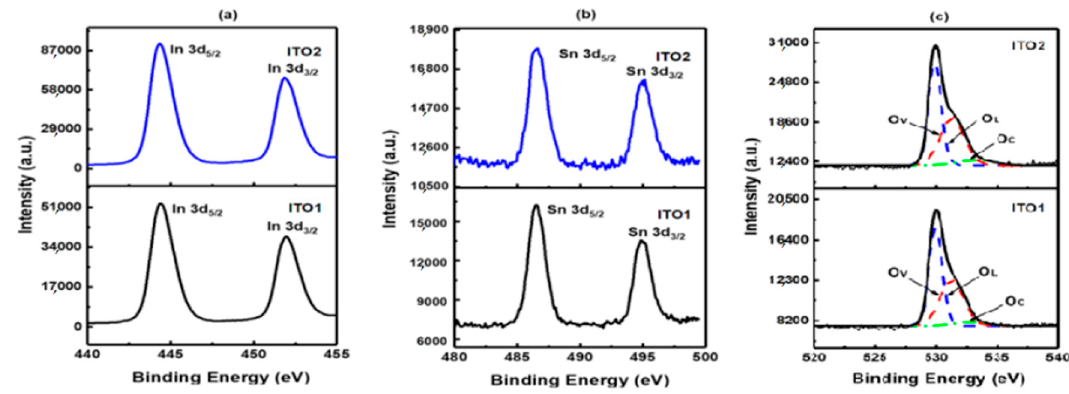
Figure 5. ( a ) XPS In 3d narrow spectra of samples: ITO1 and ITO2; ( b ) XPS Sn 3d narrow spectra of samples: ITO1 and ITO2; ( c ) XPS O 1s narrow spectra of samples: ITO1 and ITO2. Reproduced with permission from Ref. [15]; published by IOP Publishing,